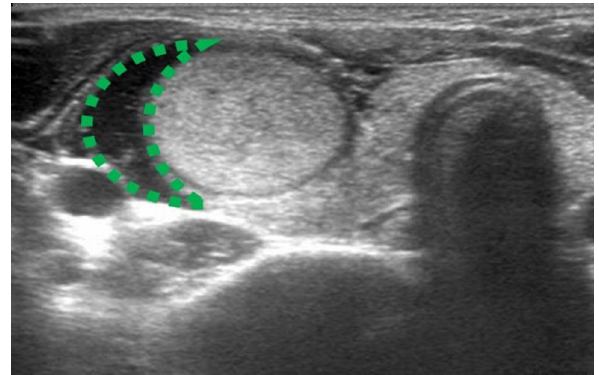
Figure 3. The hydrodissection with continuous fluid infusion. A buffering zone (green dotted line) was created to establish a liquid isolation zone > 0.5 cm in depth between the thyroid and adjacent structures.